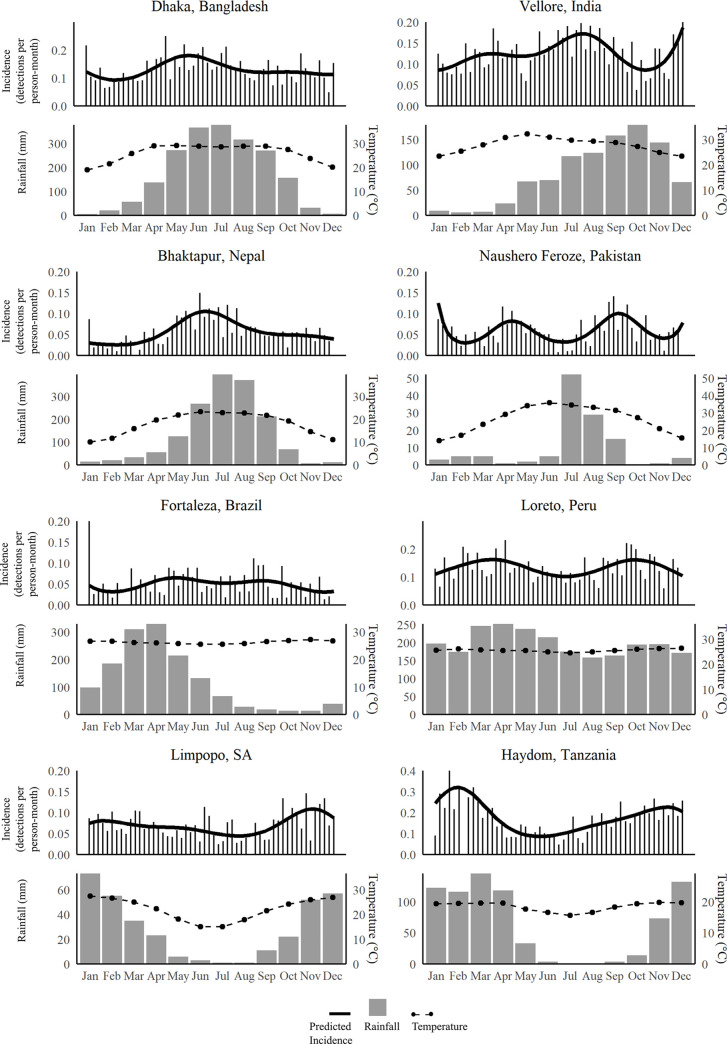
Seasonality of Shigella detections in non-diarrheal stools by site.Top plots: weekly incidence (bars) and modeled incidence (solid dark lines); bottom plots: historical monthly averages for rainfall (bars) and temperature (dotted lines) at each sites.